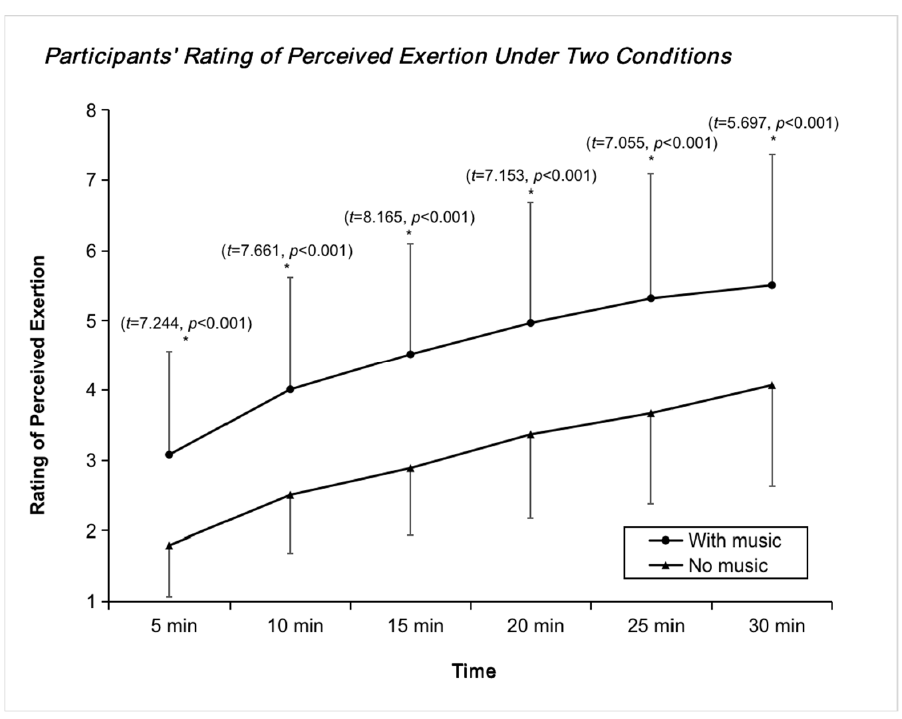
Figure 2. Trend of RPE indicators with and without music. * p < 0.05.